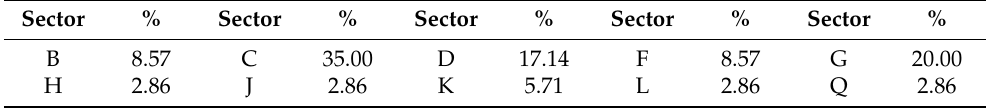
Table 1. Sector of operation of the analyzed